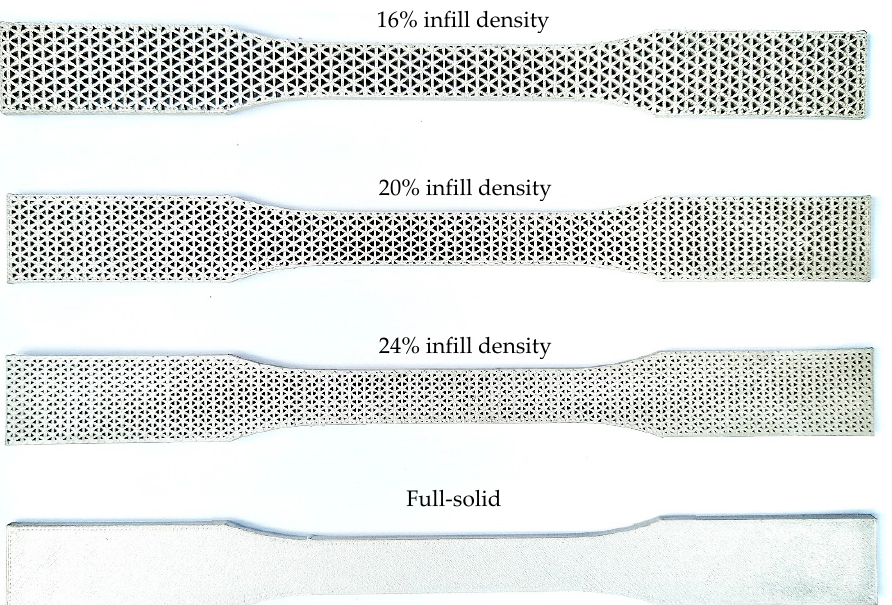
Figure 3. The finished infill and solid specimens.